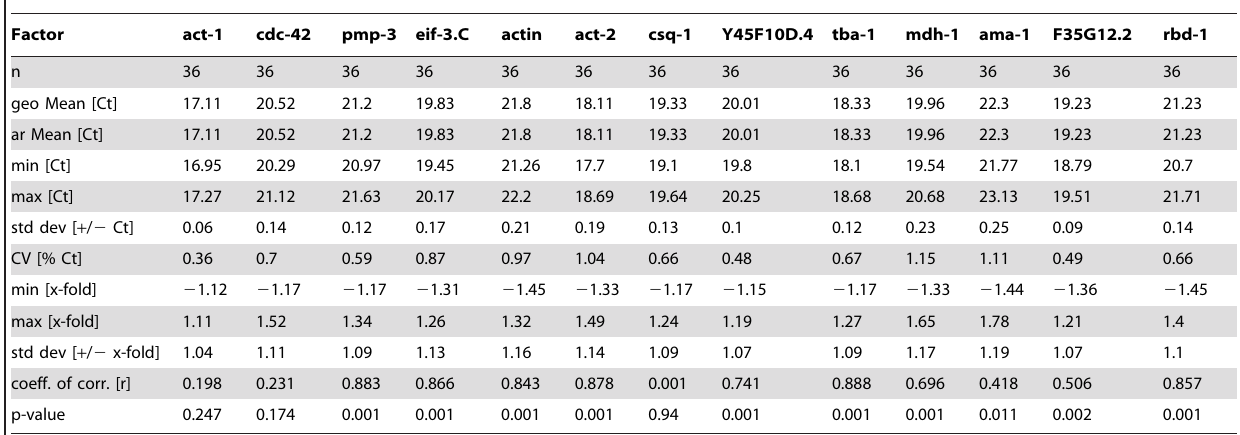
Table 4. Expression stability evaluated by BestKeeper.